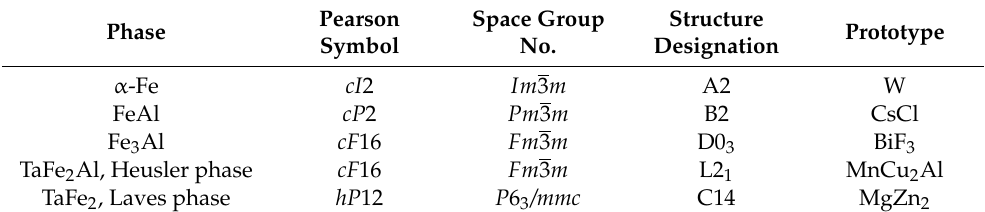
Table 2. Crystal structure data for the present phases in the Fe-25Al-2Ta